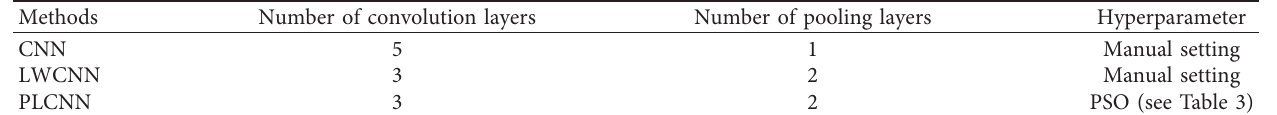
Table 4: settings of CNN, LWCNN, and PLCNN.